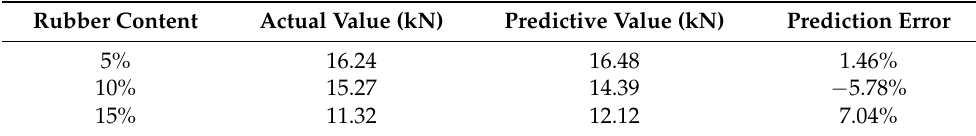
Table 12. Center frequency (9) single-parameter neural network prediction results.